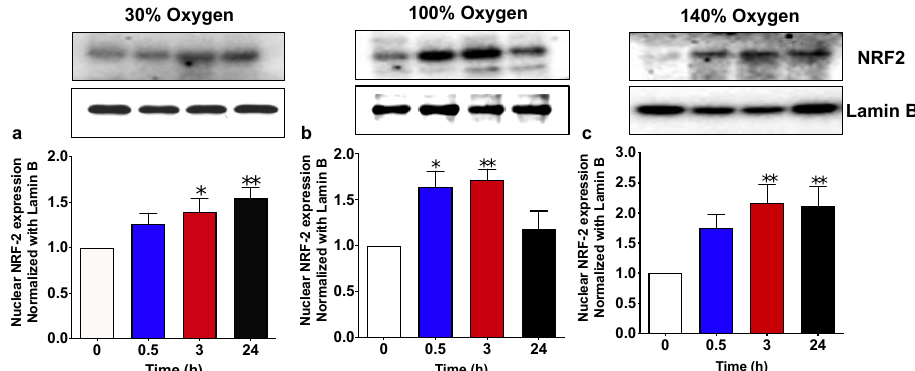
Figure 2. NRF2 nuclear translocation following 1 h hyperoxia. ( a ) Mild hyperoxia (30% O 2 ); ( b ) high hyperoxia (100% O 2 ); ( c ) very high hyperoxia (140% O 2 ) before and after the recovery to normoxic conditions. Above histograms, the picture shows a representative western blot analysis. Results are expressed as fold change (mean ± SEM) in comparison to baseline (0), which was set at 1. * p < 0.05, ** p < 0,01; for one-way ANOVA followed by Dunnett’s post hoc test.